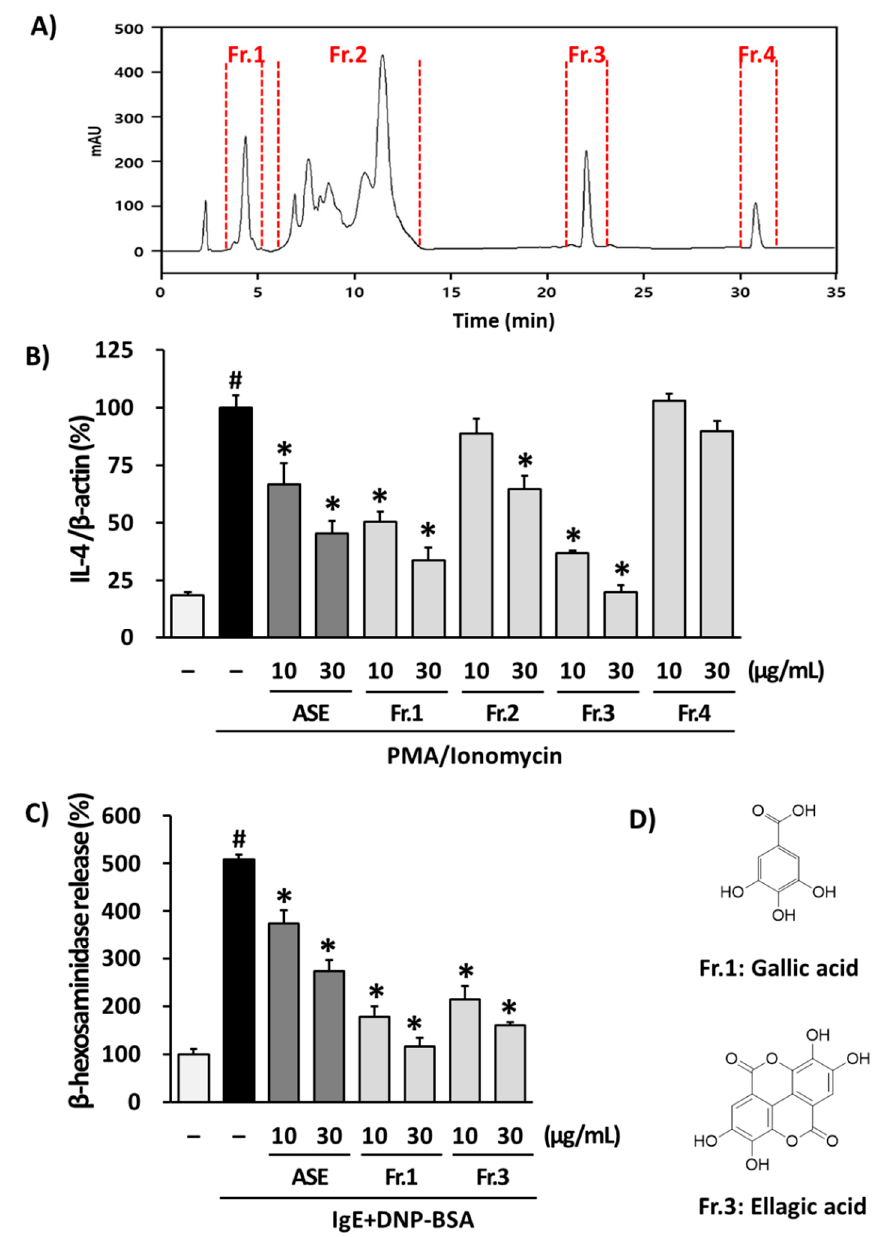
Figure 4. Anti-allergic effective acorn shell extract (ASE) fractions and active phytochemicals. HPLC chromatogram of acorn shell extract (ASE). Fr: fraction ( A ). Anti-allergic effects of ASE fractions in RBL-2H3 cells. IL-4 mRNA expression ( B ). β -hexosaminidase release ( C ). Chemical structures of active phytochemicals isolated from the acorn shell extract (ASE). Fr. 1: gallic acid; Fr. 3: ellagic acid ( D ). Data are presented as the mean ± SD, and were analyzed using a one-way ANOVA and a Tukey ′ s multiple comparisons post hoc analysis between the PMA/Ionomycin-treated group or IgE + DNP-BSA-stimulated group and the other groups. # p < 0.05 significantly greater than nontreated group. * p < 0.05 significantly lower than PMA/Ionomycin-treated group or IgE + DNP-BSA-stimulated group.